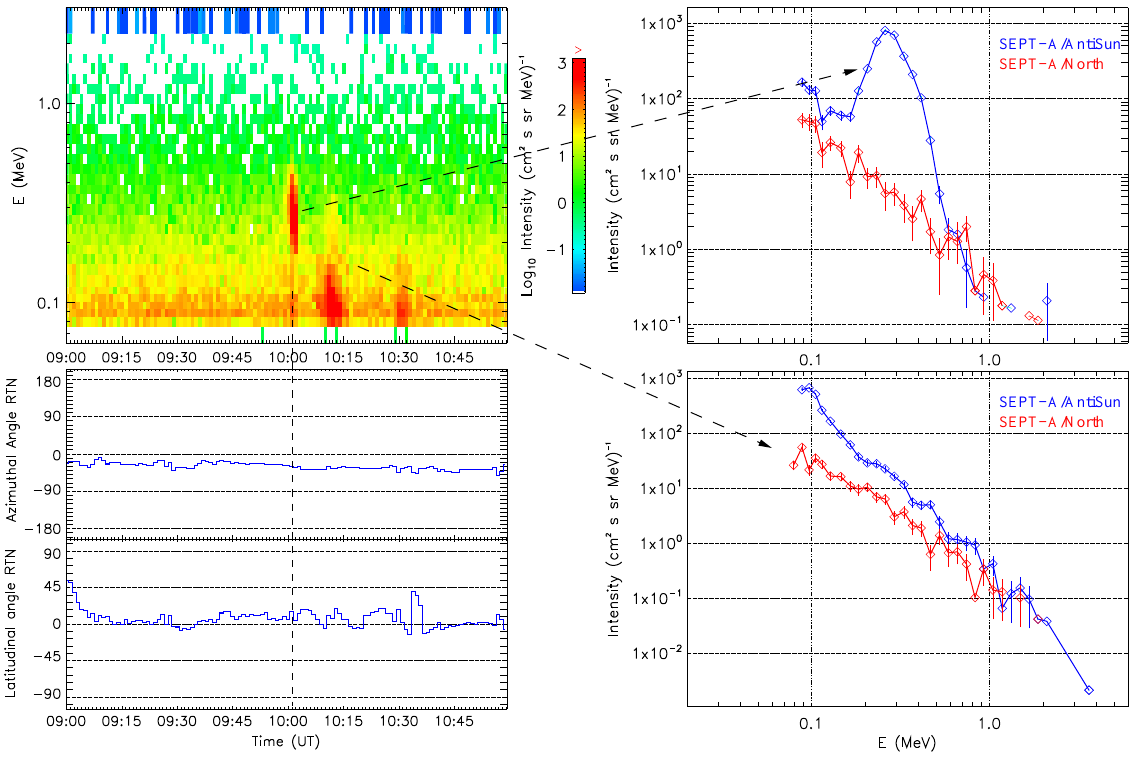
Fig. 1. Top-left, dynamic energy spectrum of an AMI event and two common upstream ion events in the range 0.1–1.2 MeV observed with SEPT-A/Antisun far upstream of the Earth’s bow–shock (656 R E ) on 2007-Feb-27. Top-right, AMI spectrum with a peak at 260 keV from SEPT-A/AntiSun (blue) and without a peak from SEPT-A/North (red) telescope. Bottom-right, for comparison the spectra of a common upstream event without any significant spectral structures. Bottom-left, the IMF components show only very small variations before and during the AMI event.